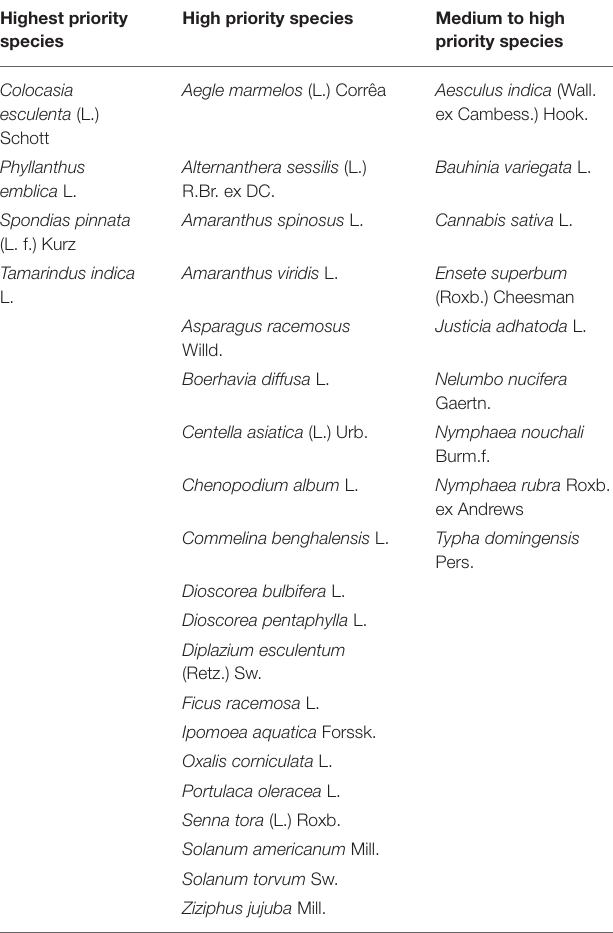
TABLE 5 | A list prioritized species based on RFC and RUV values. Highest priority